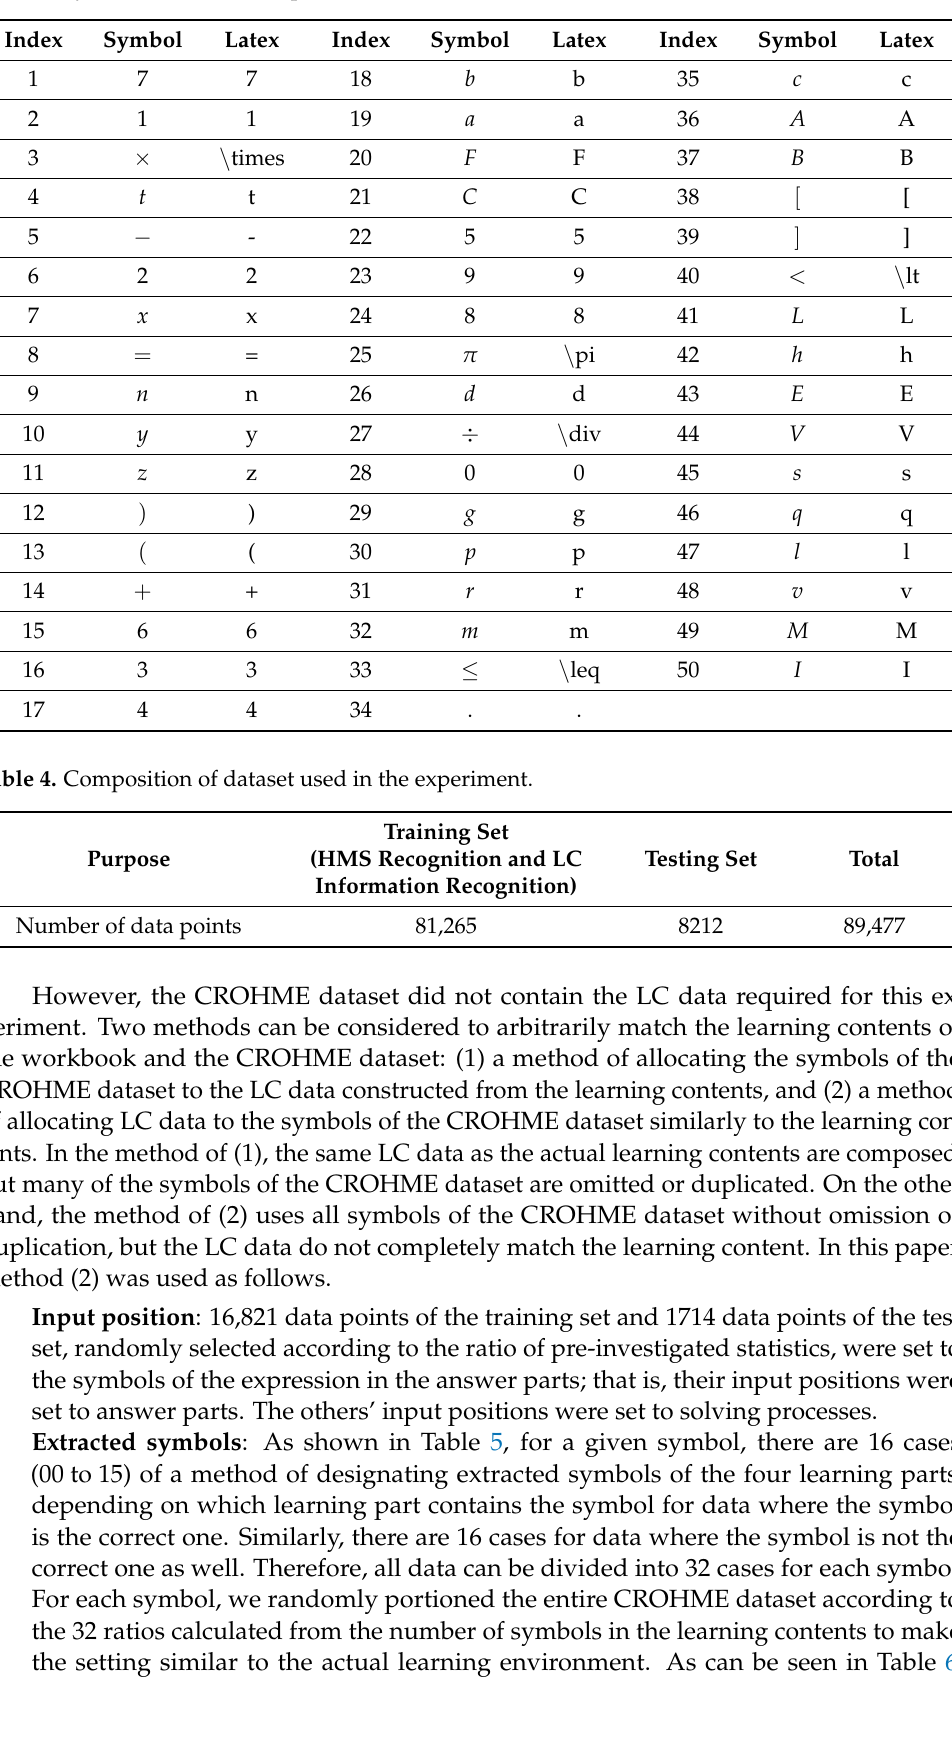
Table 3. Symbols used in the experiment.